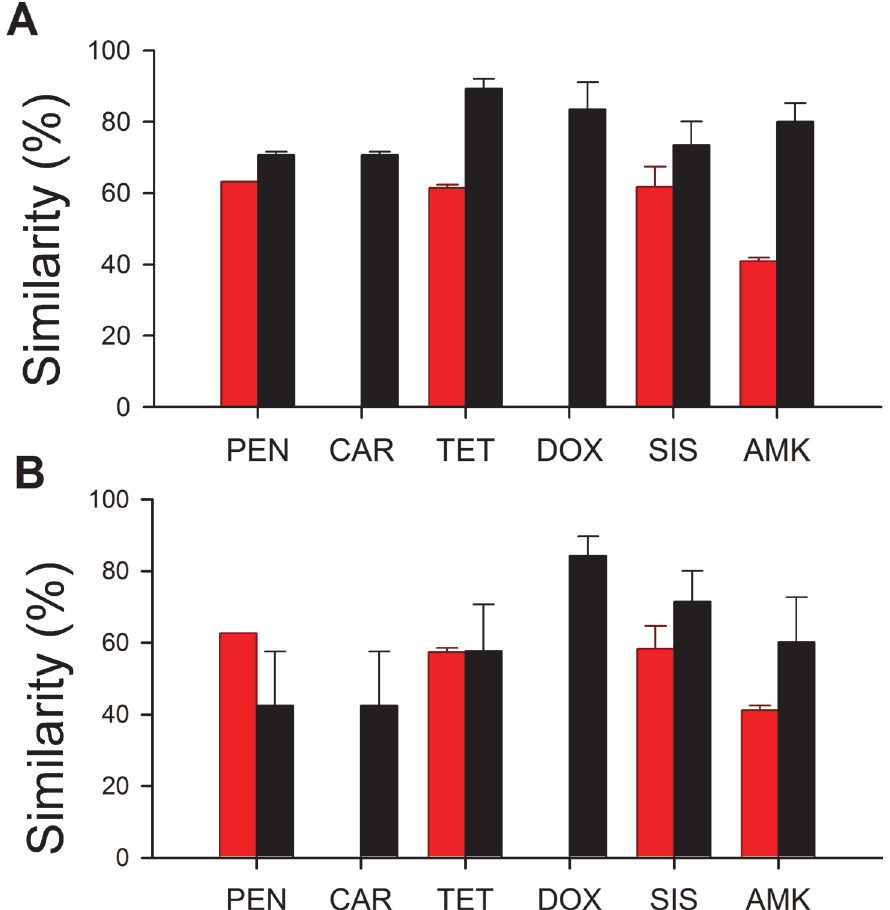
Fig 3. Nucleotide similarities of resistance genes isolated from ancient (red) and modern (black) bacteria with the closest homologous genes found in A) any bacteria or in B) a pathogenic bacteria.